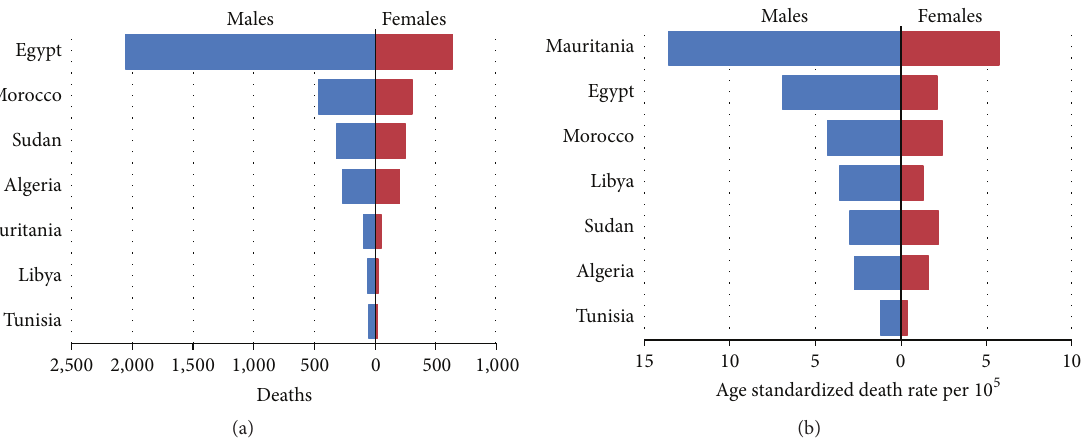
Figure 2: Mortality from HCV-associated hepatocellular carcinoma in North Africa.